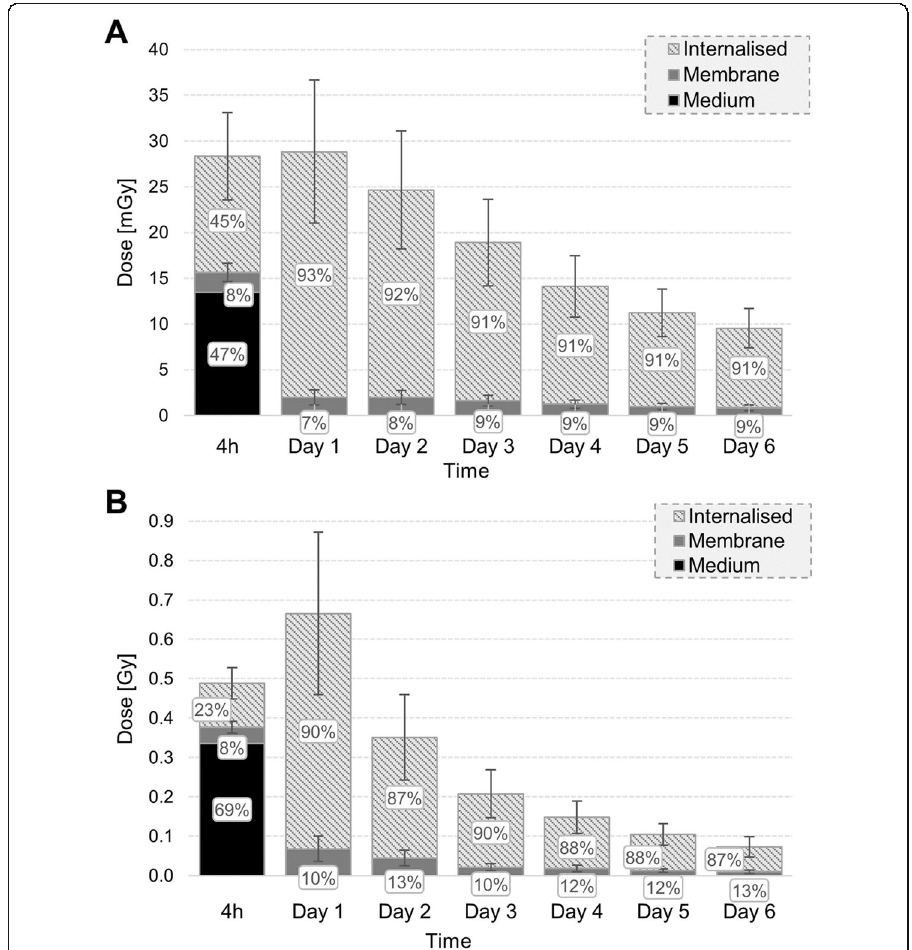
Fig. 8 Absorbed dose contribution to the nucleus from unbound, membrane bound and internalized fraction of activity (in cytoplasm) through the experiment. a corresponds to 0.1 MBq/ml and b to 2.5MBq/ml. Calculations were performed using the avarage S values of the 9 PM geometries, including the varying cross dose. The error bars indicate the SD of the absorbed dose